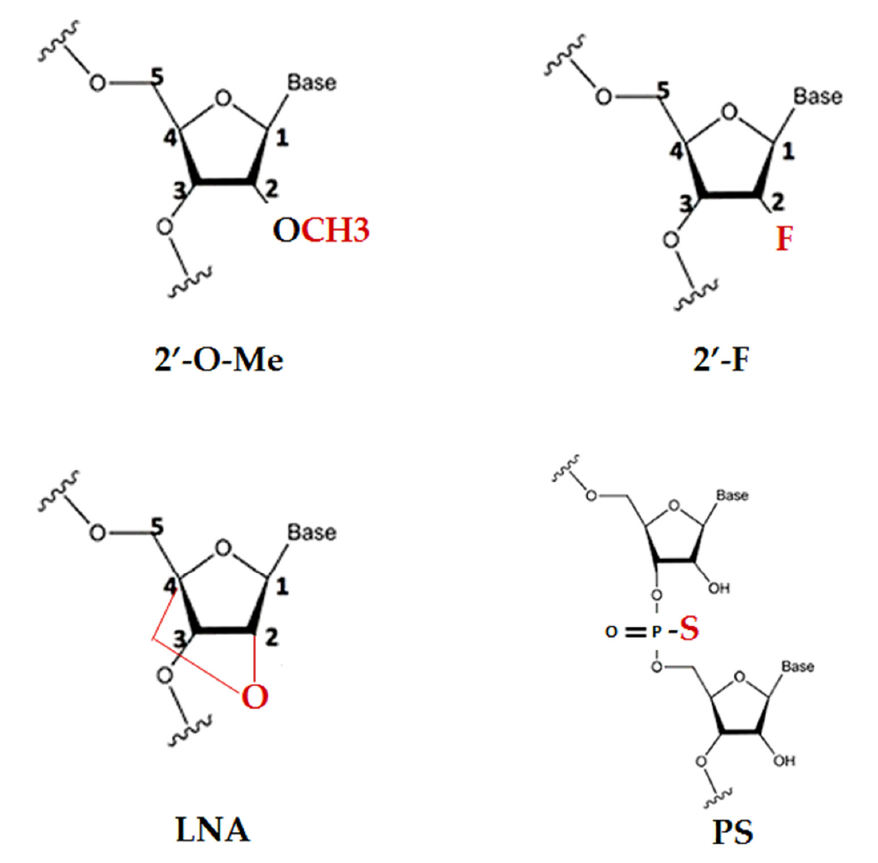
Figure 2. Examples of chemical modifications of nucleic acid analogs: 2 ′ -substitutions (2 ′ - O -methyl, and 2 ′ -fluoro); locked nucleic acid modification (LNA); 5 ′ -phosphorothioate (PS).